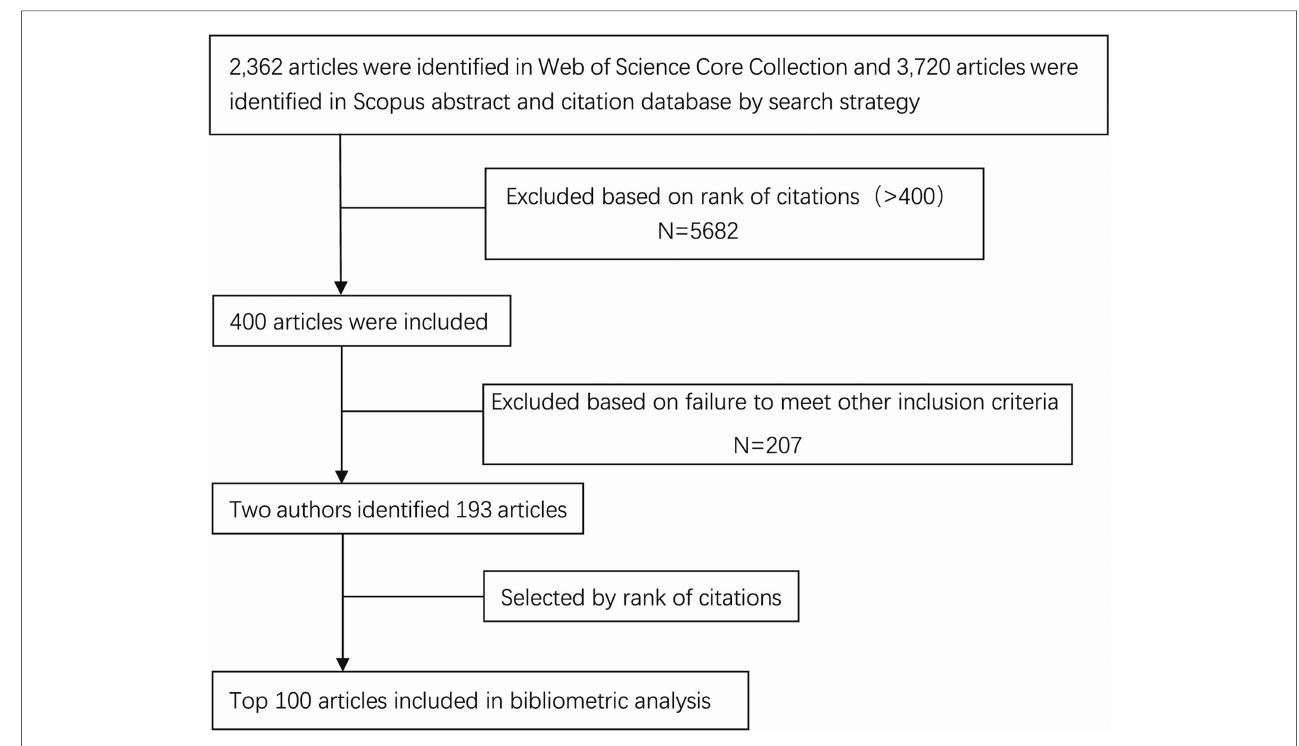
FIGURE 1 Flowchart illustrating the articles selection process, detailed procedures for screening and admission Note: A total of 2,362 and 3,720 articles were found in the Web of Science Core Collection and Scopus. The top 400 articles were selected according to citation frequency. Two reviewers selected 193 articles based on inclusion and exclusion criteria. The selected articles were ranked in order of citation frequency from high to low, and 100 articles with the highest citation frequency were selected for further